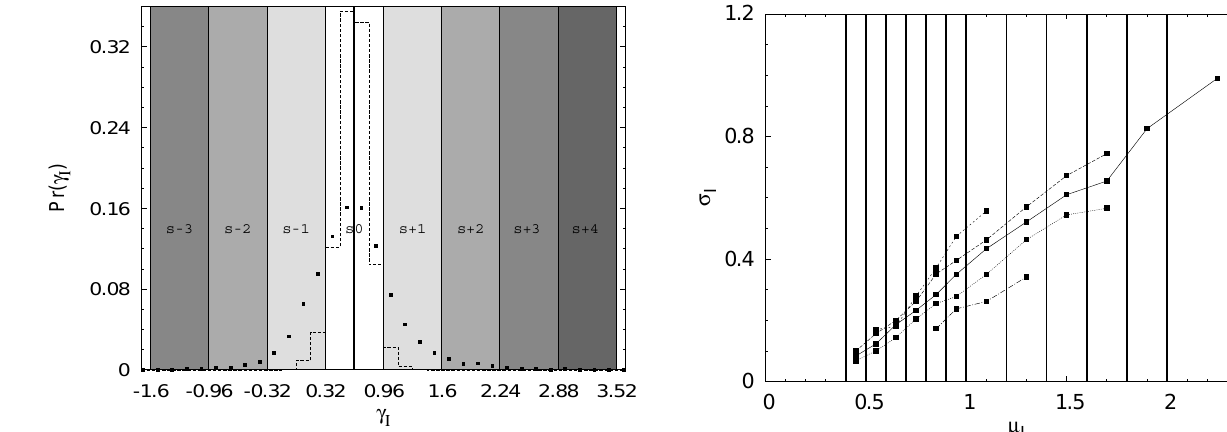
Fig. 5. The median value of the parameter σ I for a given range of µ I . The results relative to five different skewness classes are shown: s0 (solid line), s + 1 (long-dashed line), s+2 (short-dashed line), s − 1 (dotted line), and s − 2 (dotted-dashed line). Vertical lines indicate the different ranges of values of µ I used to calculate the